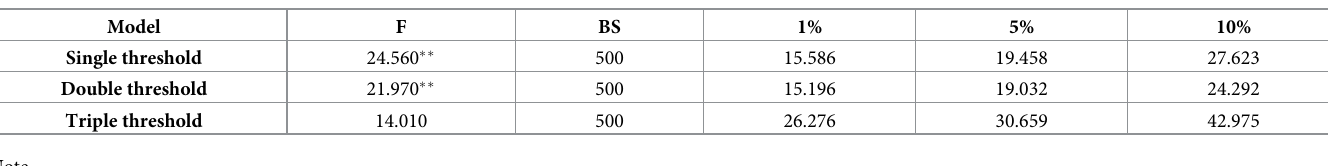
Table 3. Threshold effect test results.